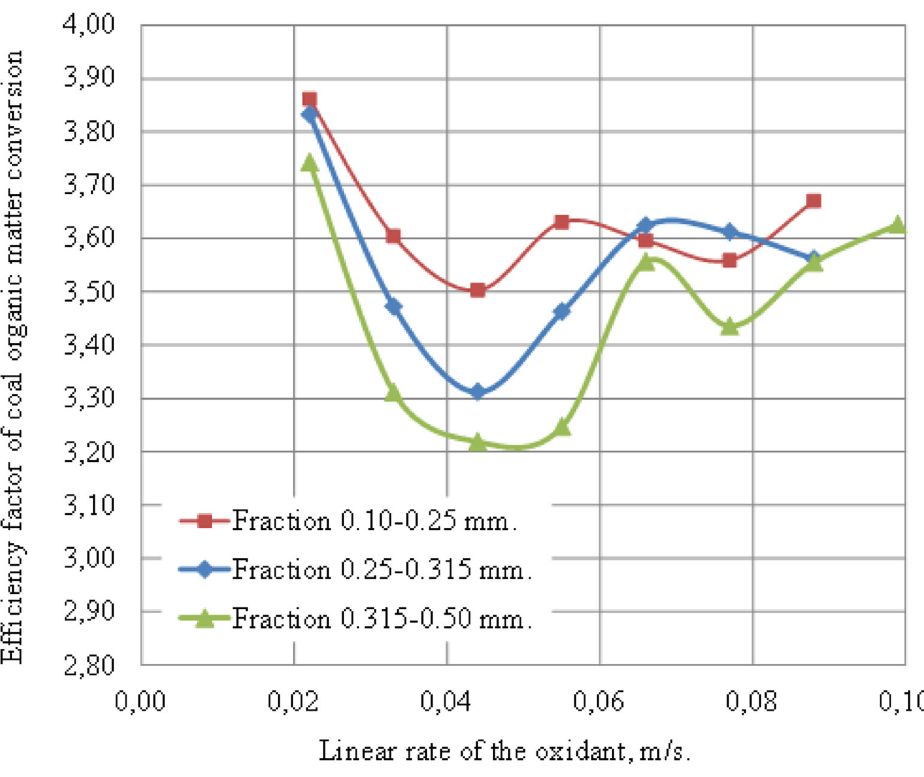
Fig. 6 Efficiency of coal organic matter conversion versus OLV and coal particles’ size